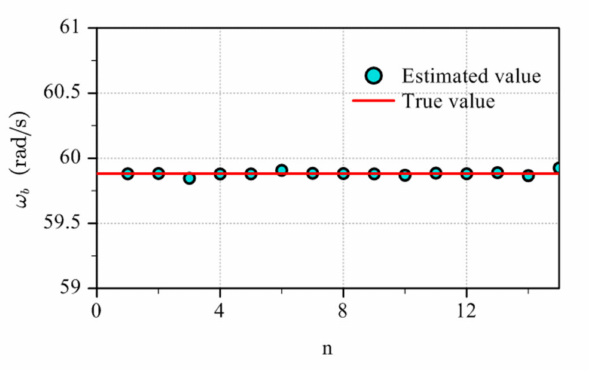
Figure 9. The objective function value of each particle.